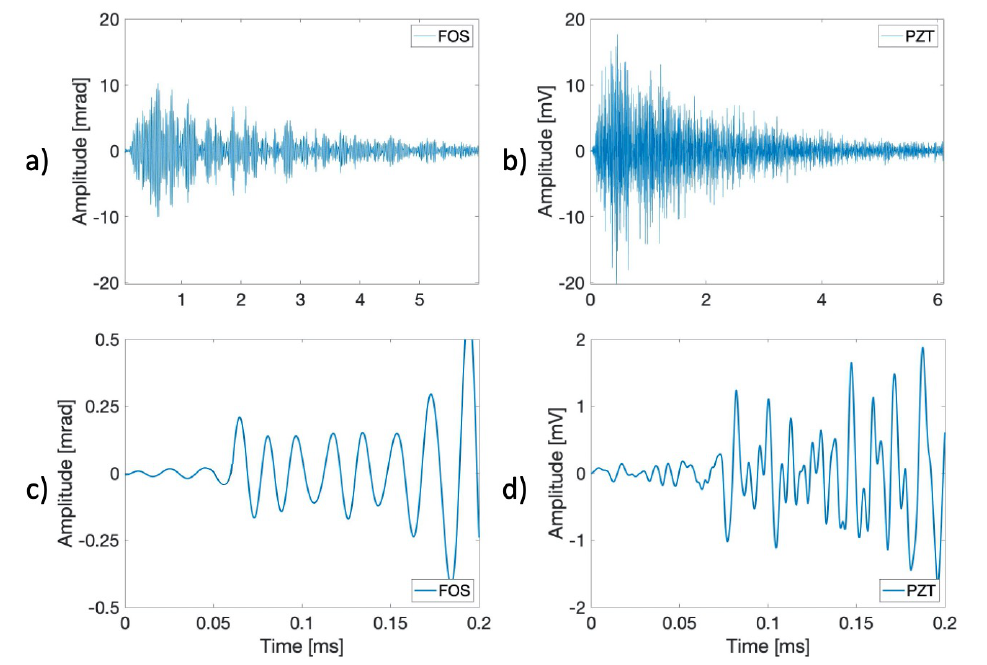
Figure 11. Comparison of the recovered signal during the fatigue growth crack test: ( a , c ) FOS- registered AE signal and ( b , d ) PZT-registered AE signal.